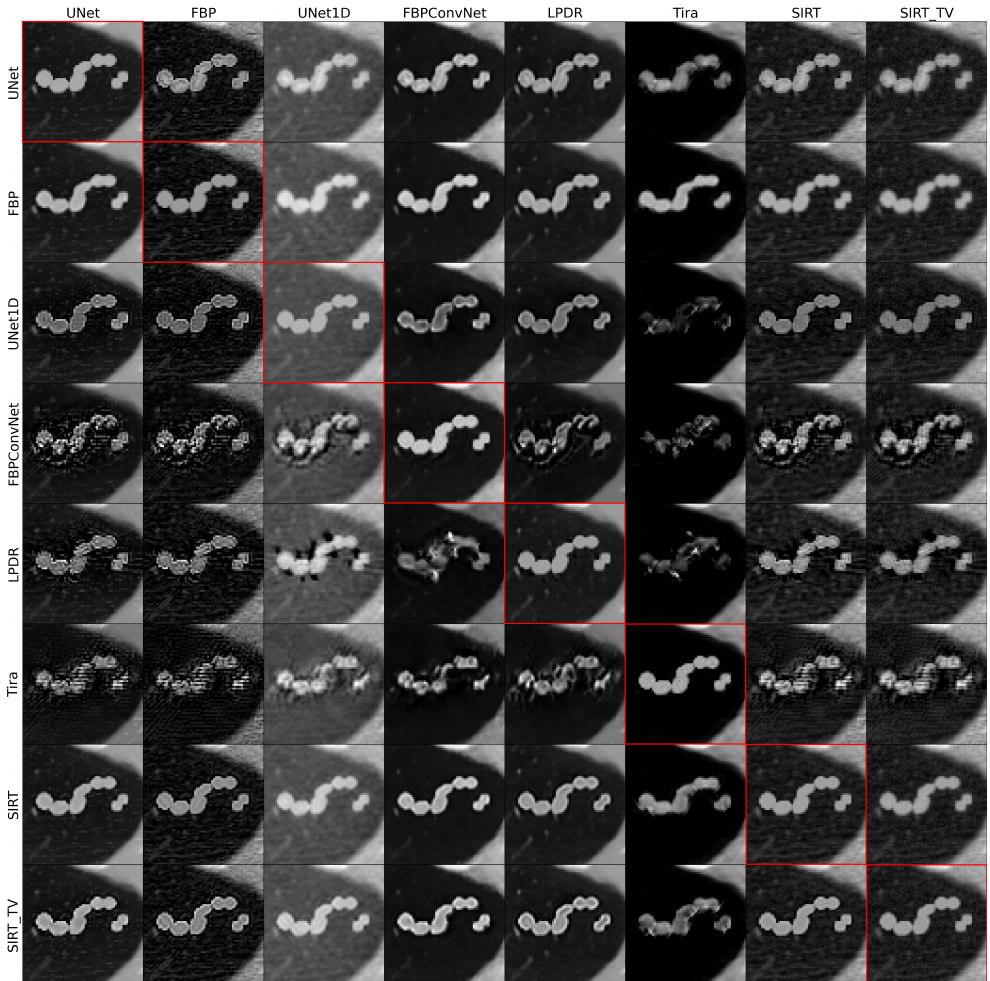
Figure 7. The figure shows areas of lung reconstructed images with an added artifact which simulates inflammation. Reconstructed images in each row of the table were created from one perturbed sinogram calculated for the neural network as indicated in the row label. Each column of the table contains reconstructed images created via an algorithm as indicated in the column